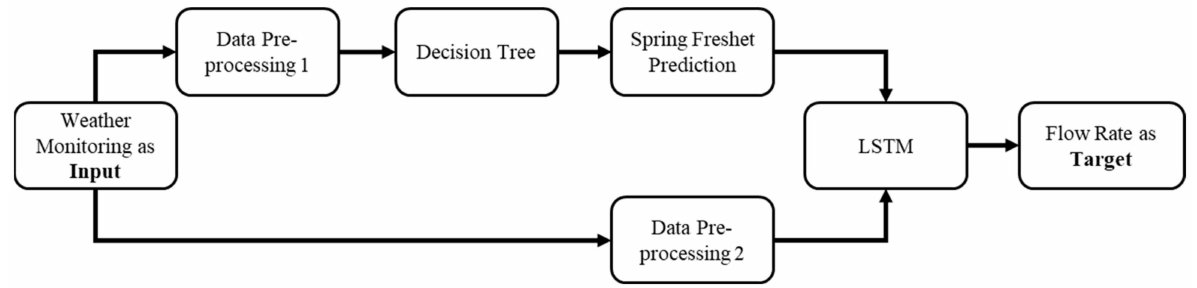
Figure 1. A schematic of the general framework of the machine learning approach to predict drainage flow rate using weather data as the